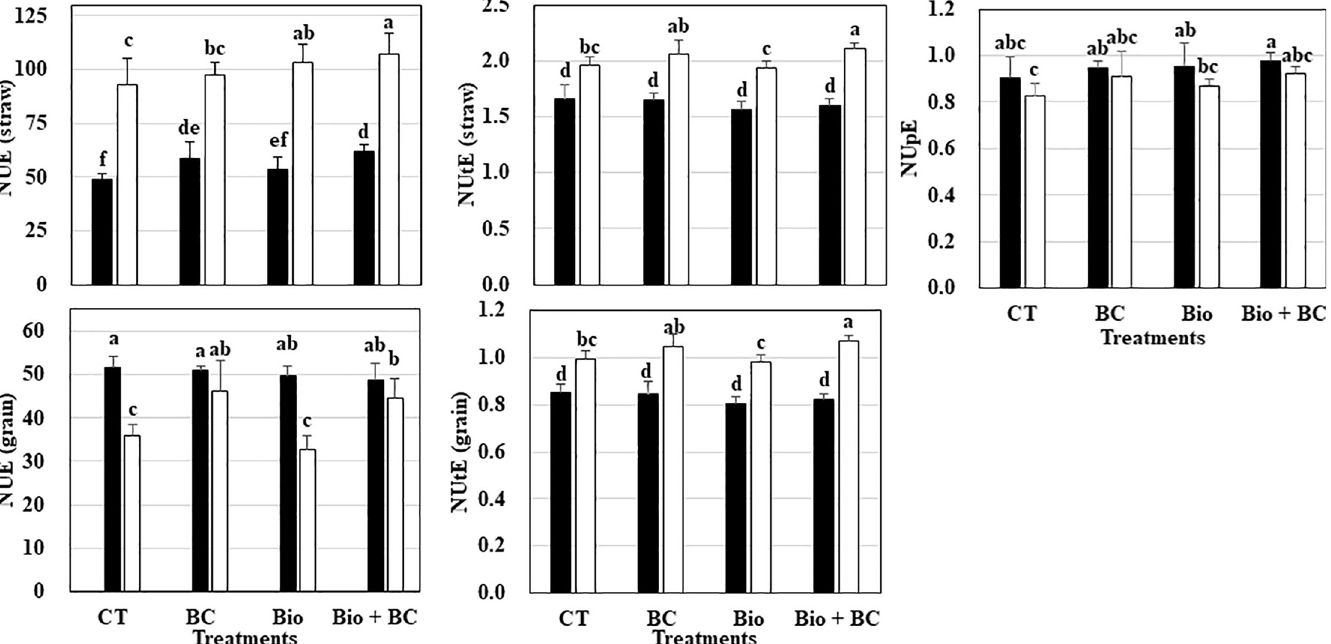
Fig 2. Nitrogen Use Efficiency parameters of two forage rice genotypes in response to different treatments. Black and white bars represent Fukuhibiki and LTAT- 29. Data are given as mean ± SD. Values indicated by the same letter are not significantly different at the 5% level by Fisher’s LSD test (p < 0.05).